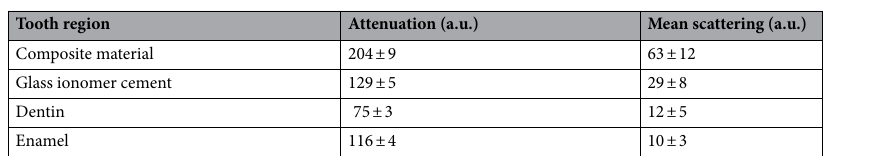
Figure 3. Attenuation and mean scattering tomography images for a tooth with fillings. A sagittal slice ( a ) and two axial slices ( b , c ) illustrate the attenuation signal. The inlet in ( c ) depicts the line-plot L4 with the attenuation (blue) and scattering strength (orange). In ( d ), histograms illustrate the attenuation and mean scattering strength for different tooth regions. The composite material filling and the glass ionomer cement (GIC) are depicted as well. In ( e , f ), the mean scattering signal corresponding to the attenuation slices is shown. Some cracks are visible in this contrast modality and are oblique in the attenuation signal, as indicated by white arrows. Tooth